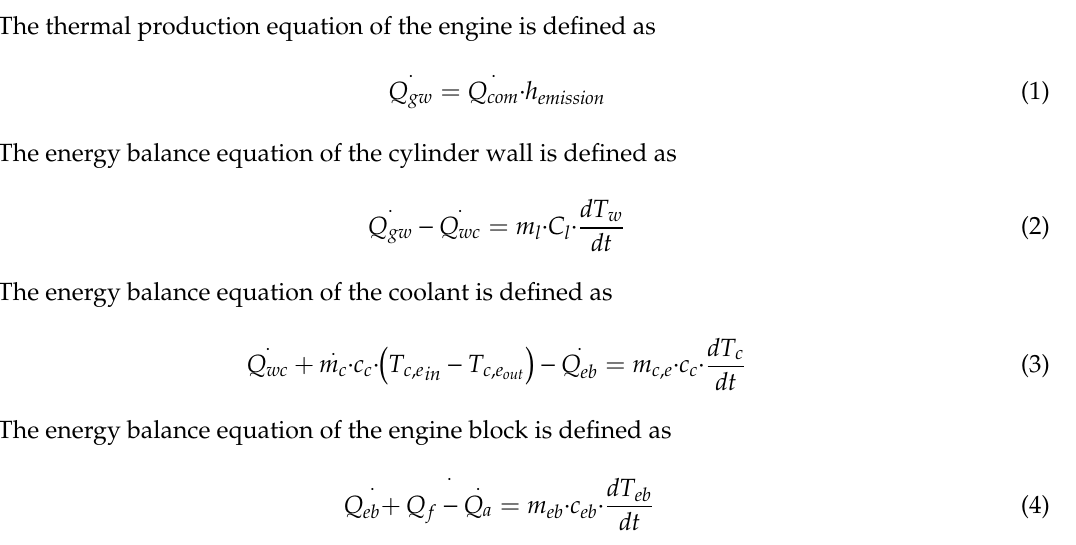
Figure 3. Engine internal thermal transmission process.